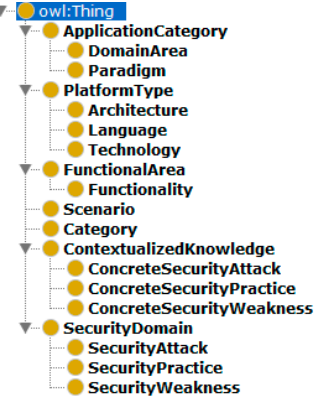
Figure 7. Ontology design in Protégé editor.